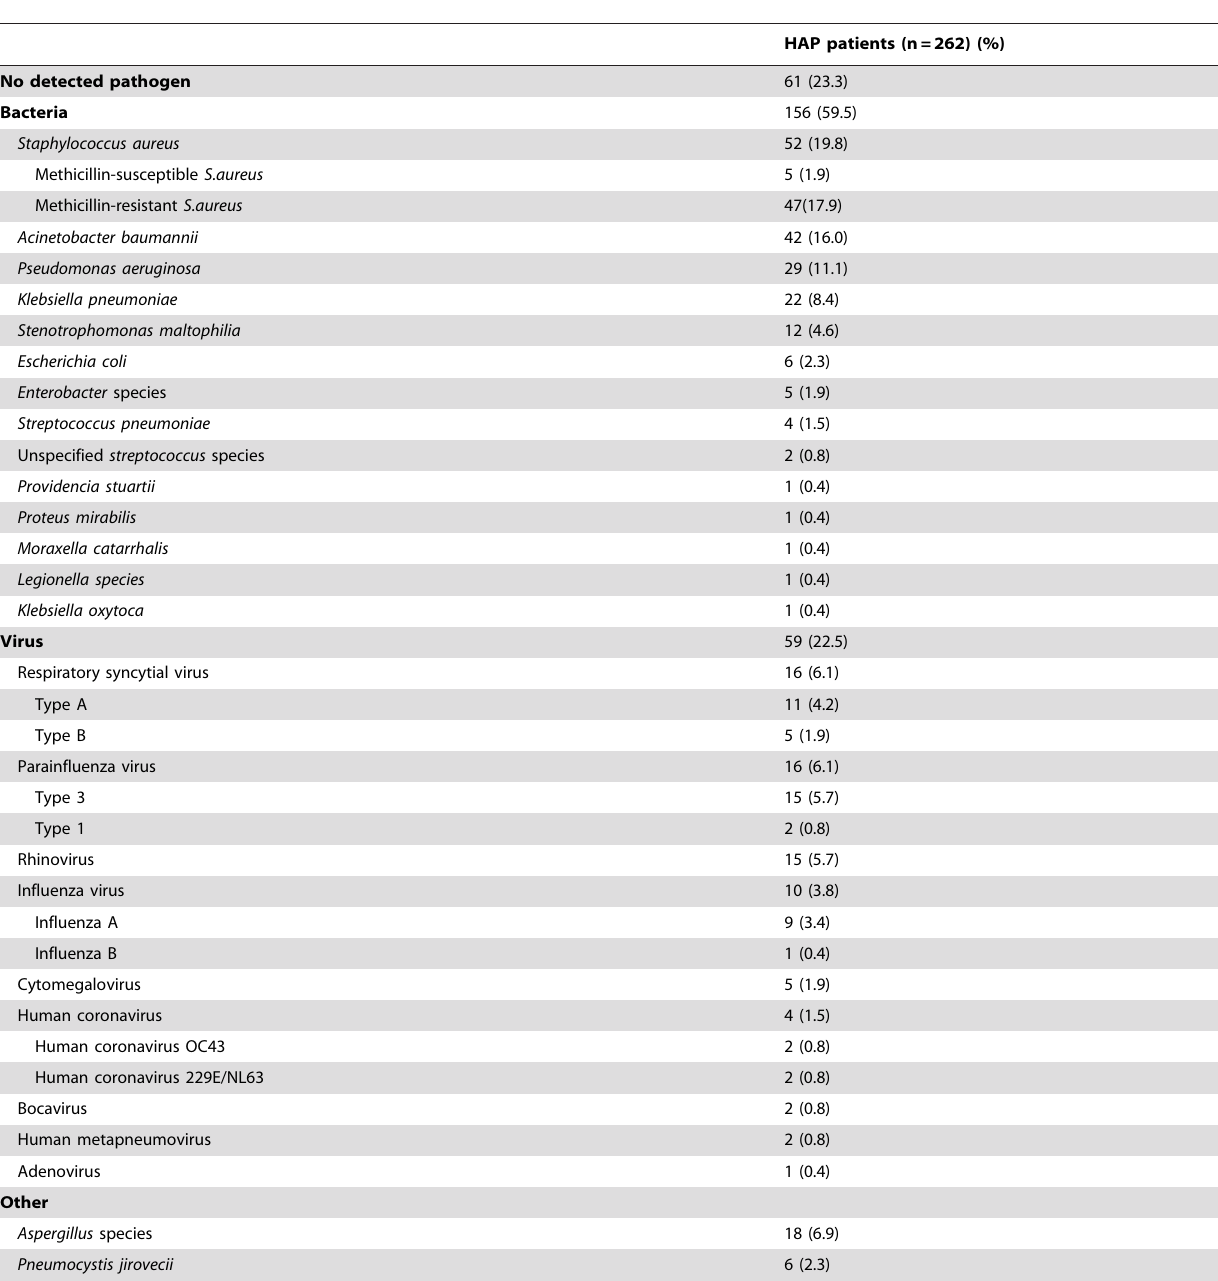
Table 2. Identity of pathogens in patients with severe hospital-acquired pneumonia a